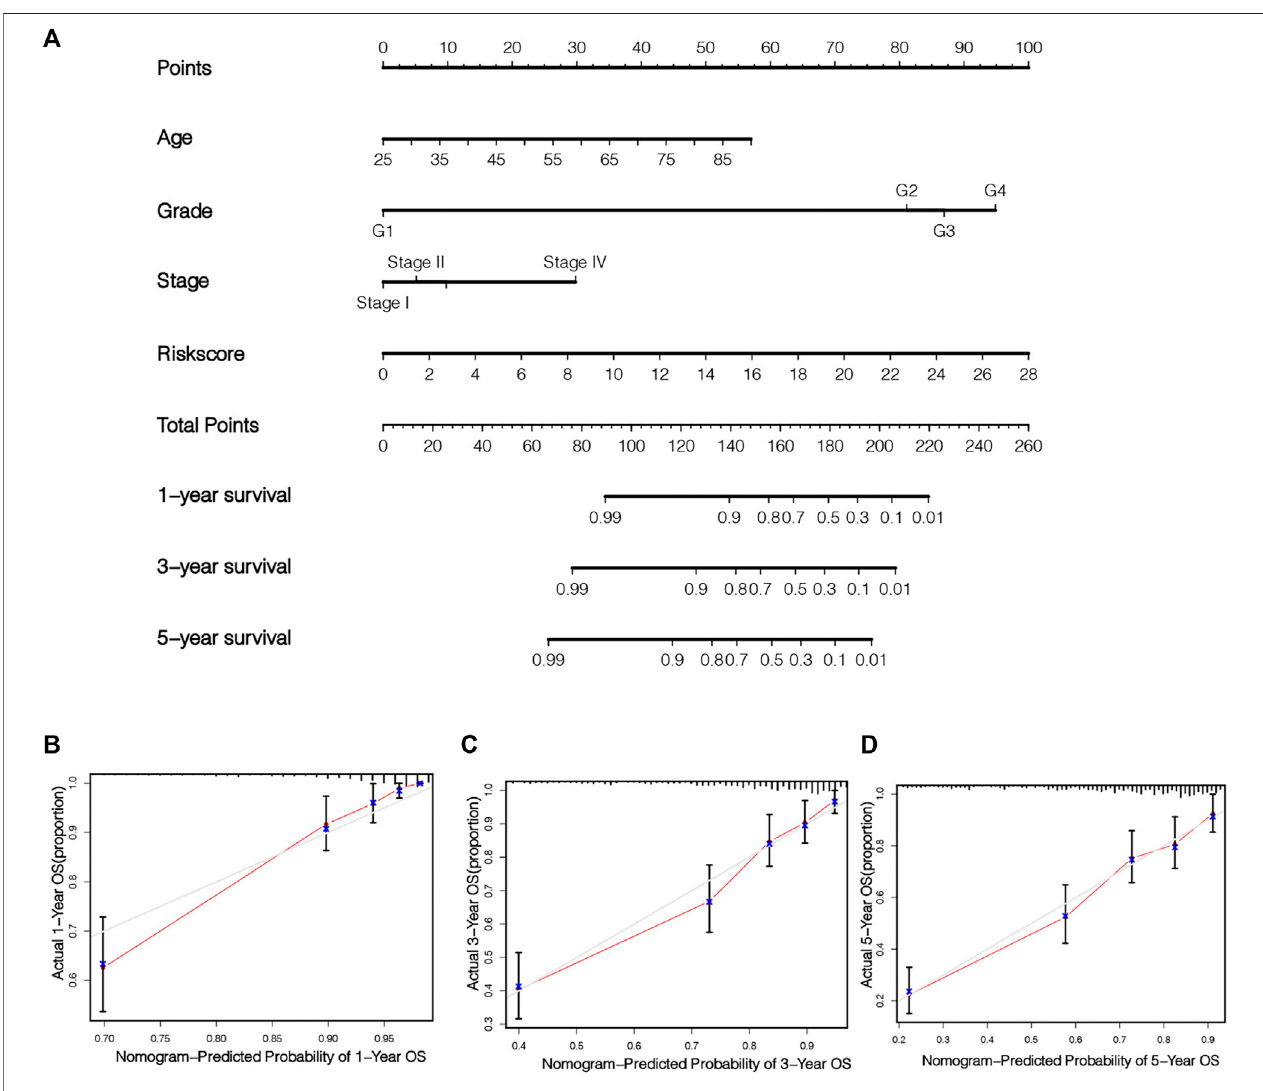
FIGURE 8 | Establishment and veri fi cation of nomogram. Combined with age, stage, grade and risk score, a nomogram was established to quantitatively predict the 1, 3 and 5 years survival of KIRC patients (A) . The calibration chart illustrates the prediction ability of this nomogram (B – D) .